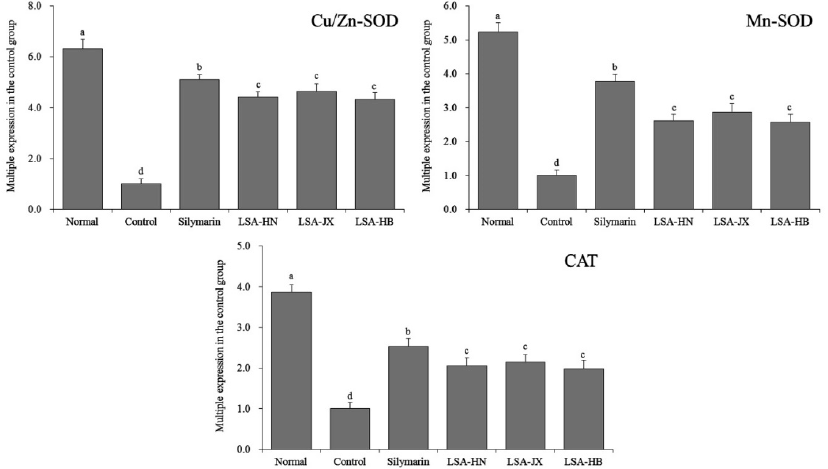
Figure 2. The TNF- α , NF- κ B and I κ B- α mRNA expression in liver of mice. a–d Mean values with different superscript letters are significantly different ( p < 0.05) by the Duncan’s multiple-range test.